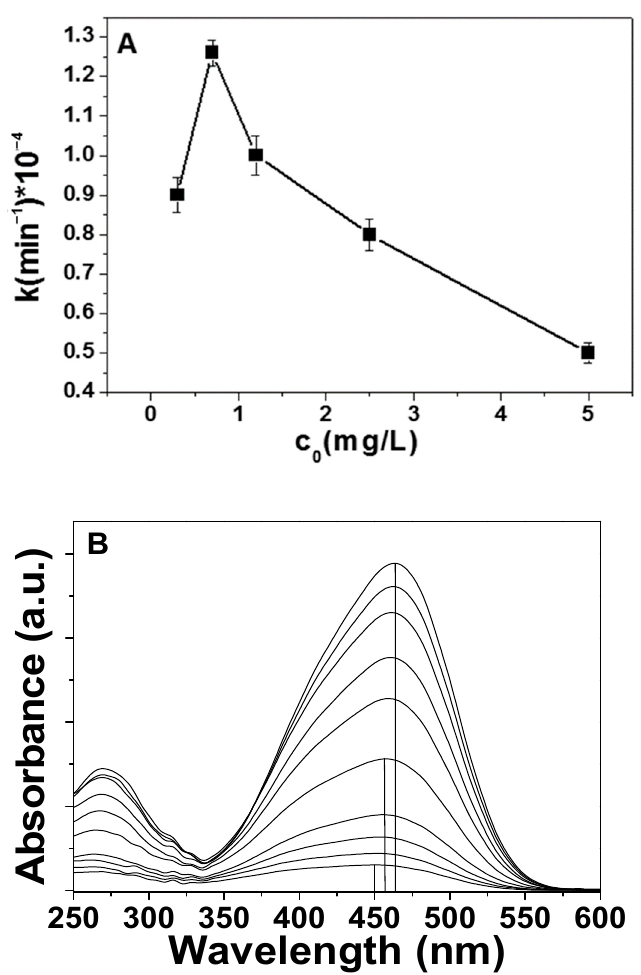
Figure 3. ( A ) Influence of the dye concentration c 0 on the degradation rate (TiO 2 = 0.79 g/cm 3 ; Q = 0.066 L/s, h w = 13.5 cm, test no. 7. ( B ) MO UV–Vis absorption spectrum decay during the photo-degradation. MO = 5 mg/L; TiO 2 = 0.79 g/cm 3 ; Q = 0.066 L/s, h w = 13.5 cm.